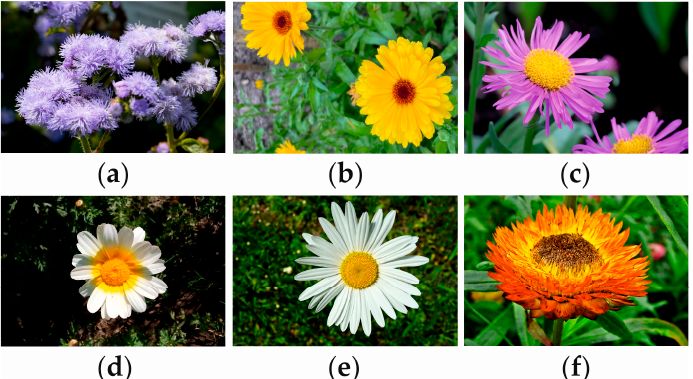
Figure 1. The six ornamental Asteraceae species studied: Ageratum houstonianum ( a ), Calendula officinalis ( b ), Callistephus chinensis ( c ), Glebionis carinata ( d ), Leucanthemum vulgare ( e ), Xerochrysum bracteatum ( f ).